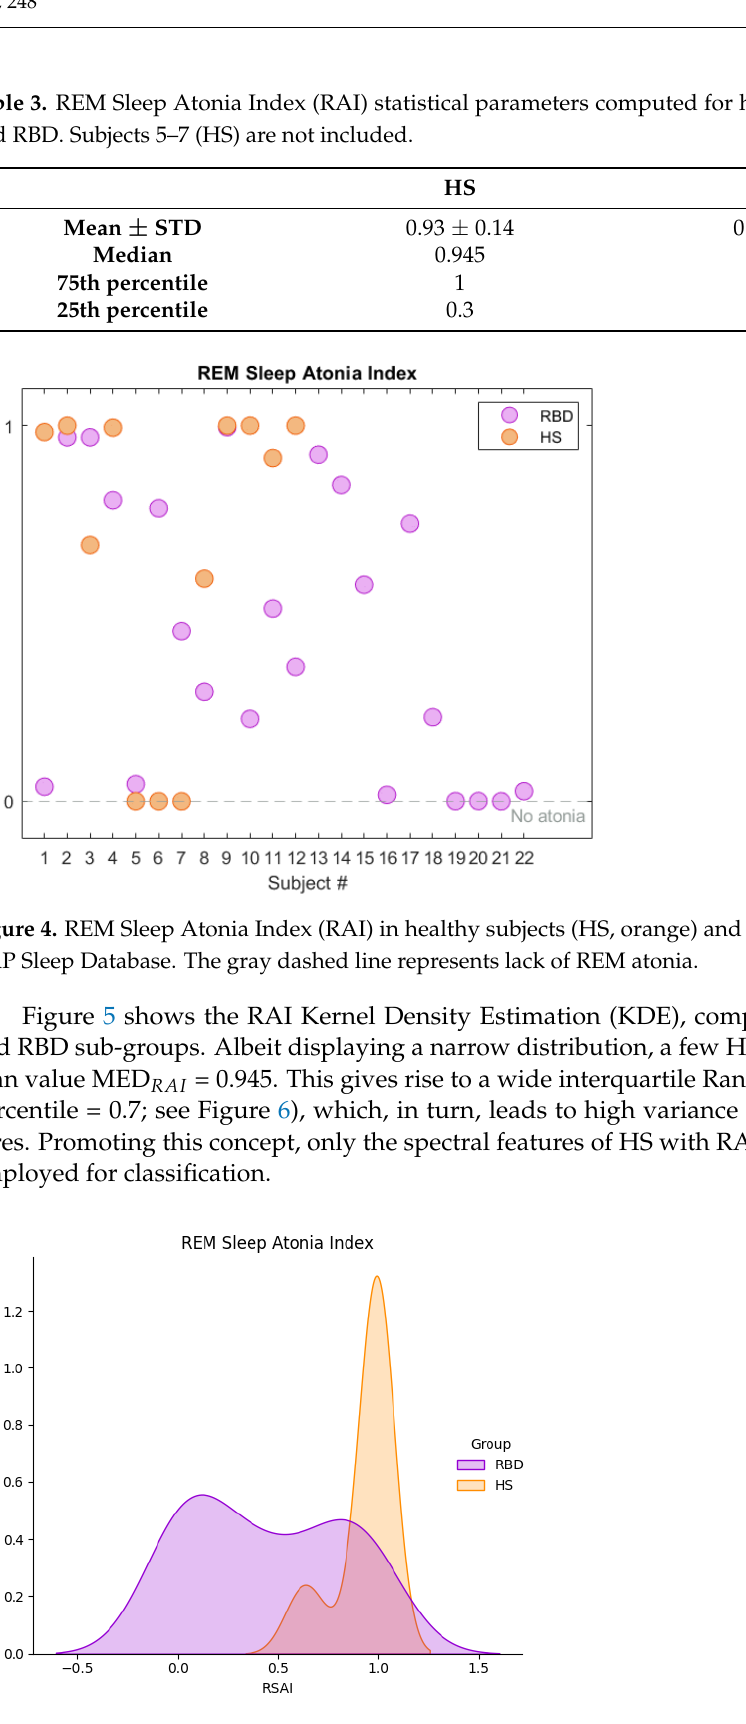
Figure 5. REM Sleep Atonia Index (RAI) Kernel Density Distribution in HS (orange) and RBD subjects (purple), in the CAP Sleep Database. RBD subjects present with a wider RAI